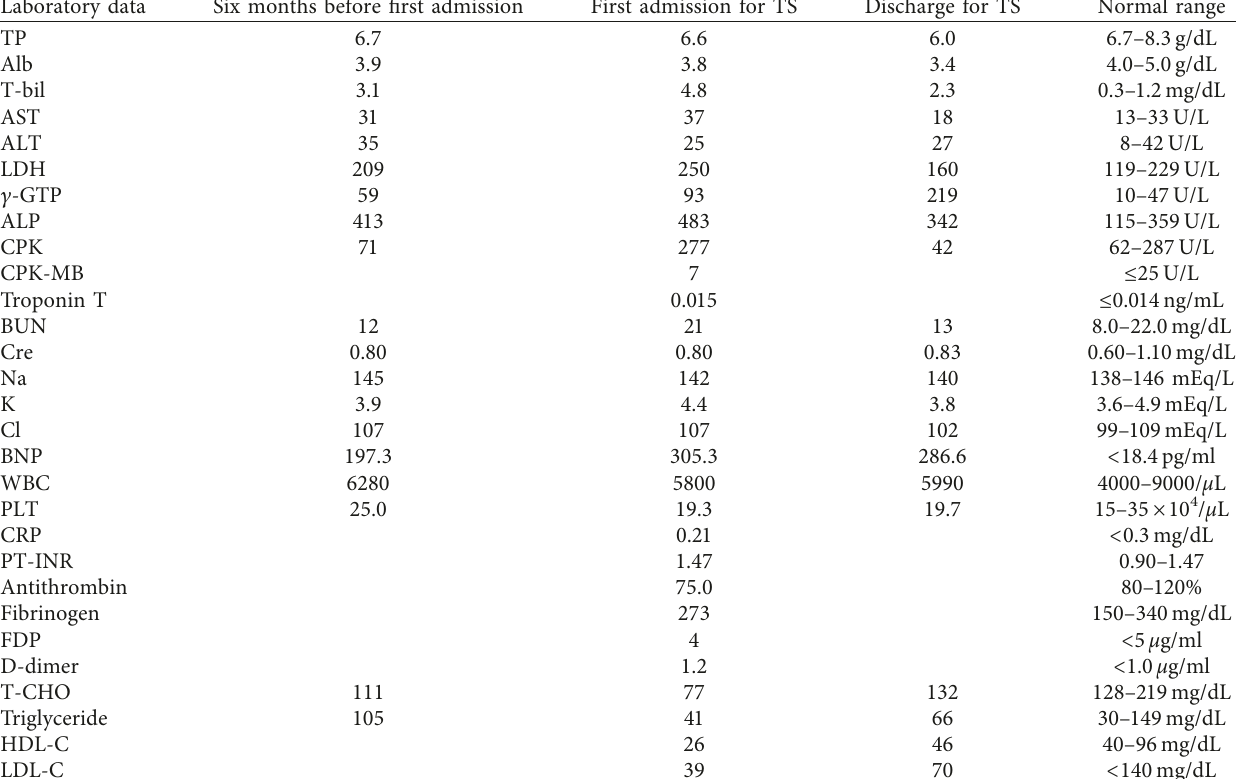
Table 1: Laboratory data at 6 months before the first admission, on admission, and at the time of discharge for thyroid storm. Laboratory